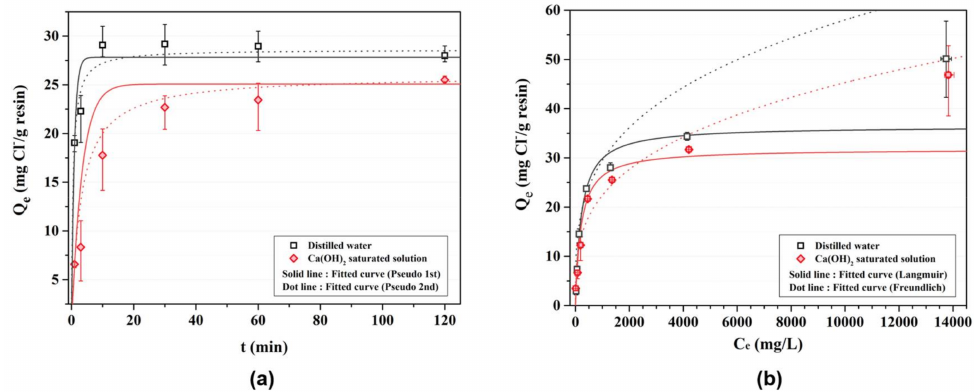
Figure 3. Results of the kinetic and equilibrium test of the AER in the chloride solutions—non-linear curve: ( a ) kinetic behavior of the AER; and ( b ) equilibrium behavior of the AER.